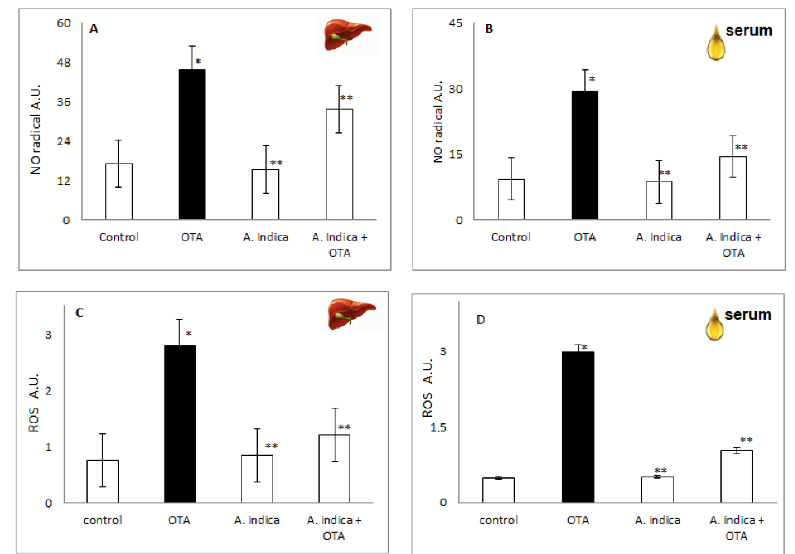
Figure 7. ( A , B ) NO radicals measured in arbitrary units (A.U.) in serum/liver of control mice, mice treated with OTA, mice treated with A. indica oil and with combination A. indica oil + OTA; ( C , D ) ROS (A.U.) measured in serum/liver of OTA treated mice, group protected with A. indica oil only and pretreatment with A. indica oil + OTA compared to healthy mice. The presented data as means with SEM. (*) indicate significant differences from (* p < 0.05 vs. control, ** p < 0.05 vs. OTA).